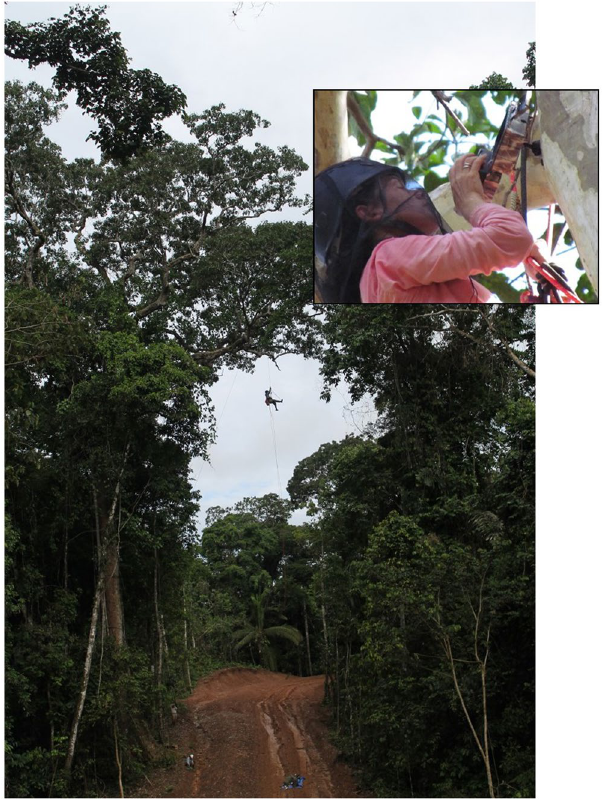
Figure 5. TG climbing a canopy bridge over a recently cleared natural gas pipeline in the Lower Urubamba Region of Peru to place and program (inset) camera